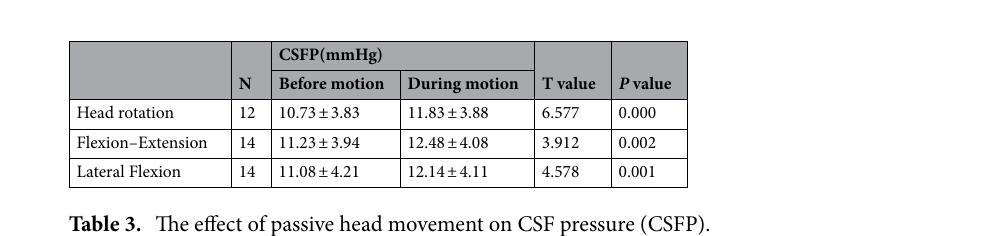
Table 3. The effect of passive head movement on CSF pressure